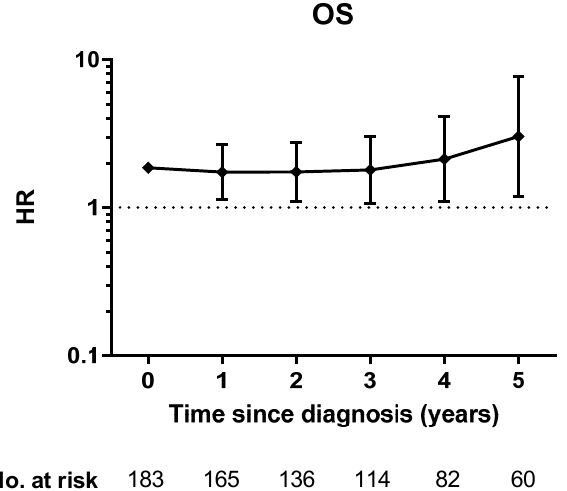
Figure 1. Plot of adjusted hazard ratio (diamonds) of CCES 1 vs. CCES 0 in patients who had already survived up to 5 years after diagnosis, 95% CIs are depicted as bars.